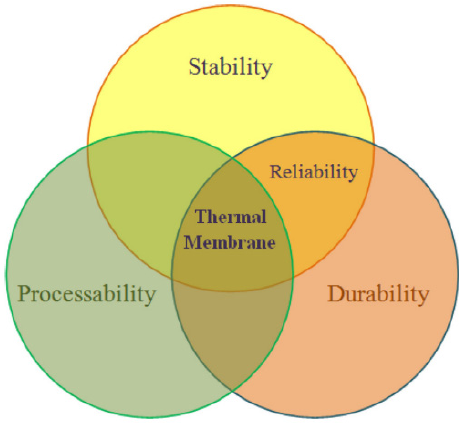
Figure 11. The target to develop thermally stable polymers [81].